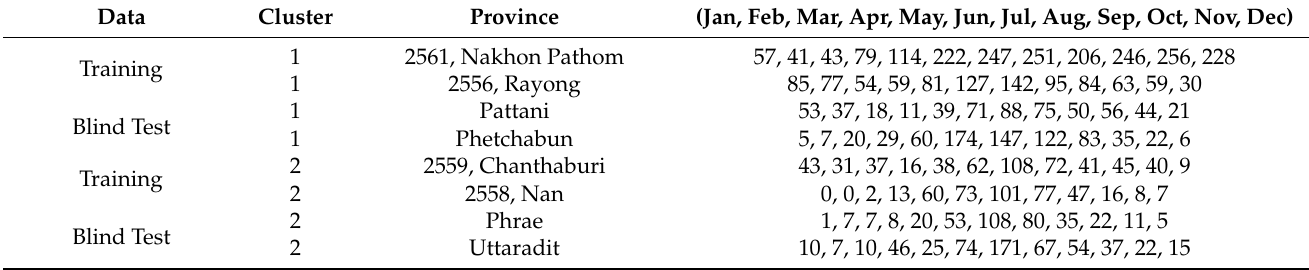
Table 11. The example of clustering results from the selected models for the dengue fever dataset for the month category.